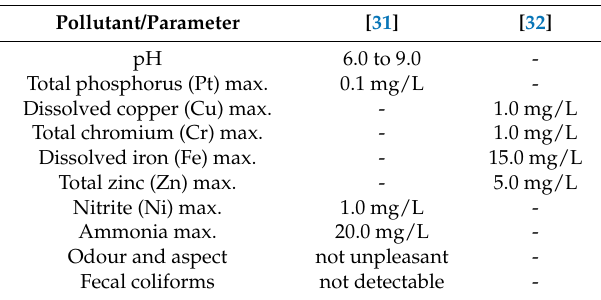
Table 3. Water quality limits for non-potable